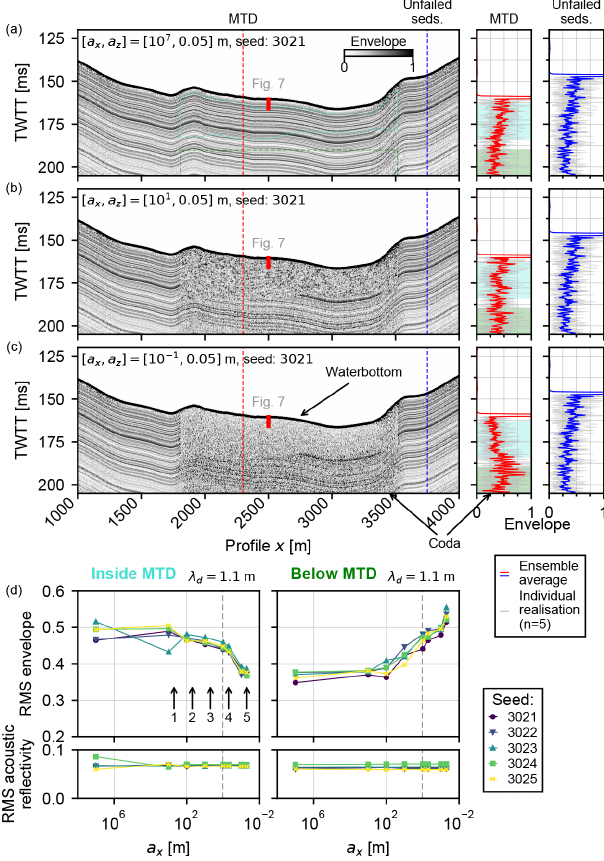
Figure 6. Multi-source synthetic experiment results. (a–c) Syn- thetic AUV sub-bottom profiles of the seismic response (envelope of trace amplitude) to progressively decreasing lateral correlation length, a x (i.e. increasing deformation). Side panels (right) show the trace envelopes for the individual model realisations (gray) and the rms amplitude of all realisations for traces intersecting the MTD (red) and unfailed sediments (blue). The two amplitude analysis windows are highlighted in cyan (internal MTD window) and green (below MTD deposit window). (d) The rms of the trace envelope (top) and rms vertical-incidence acoustic reflectivity against lat- eral correlation length ( a x ) for all realisations (bottom), both in- side the MTD (left; cyan window in a ) and below the MTD (right; green window in a ). λ d shows the dominant wavelength of the seis- mic source in the sediment layers. “MTD” corresponds to mass- transport